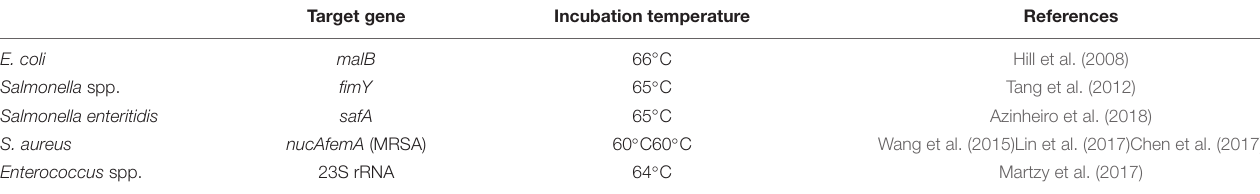
TABLE 1 | Target genes and protocols for LAMP assays.